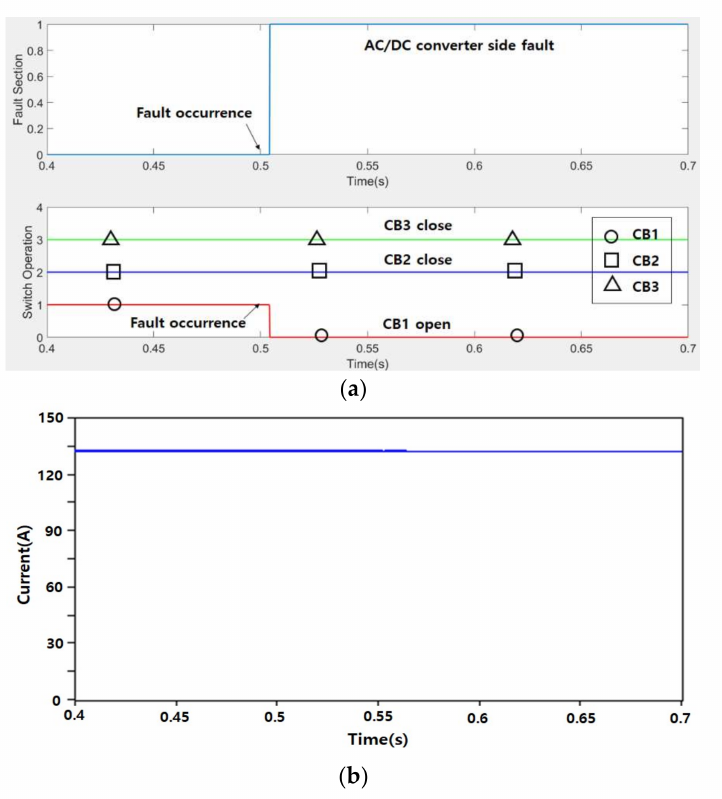
Figure 13. Simulation results of Case 1: ( a ) Fault section and CB operation and ( b ) Load